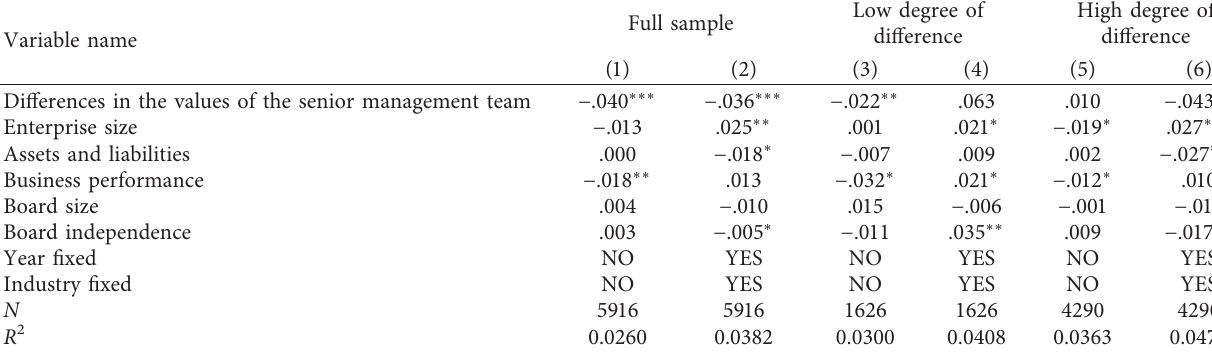
Table 6: Regression analysis results of differences in the values of the senior management team and innovation